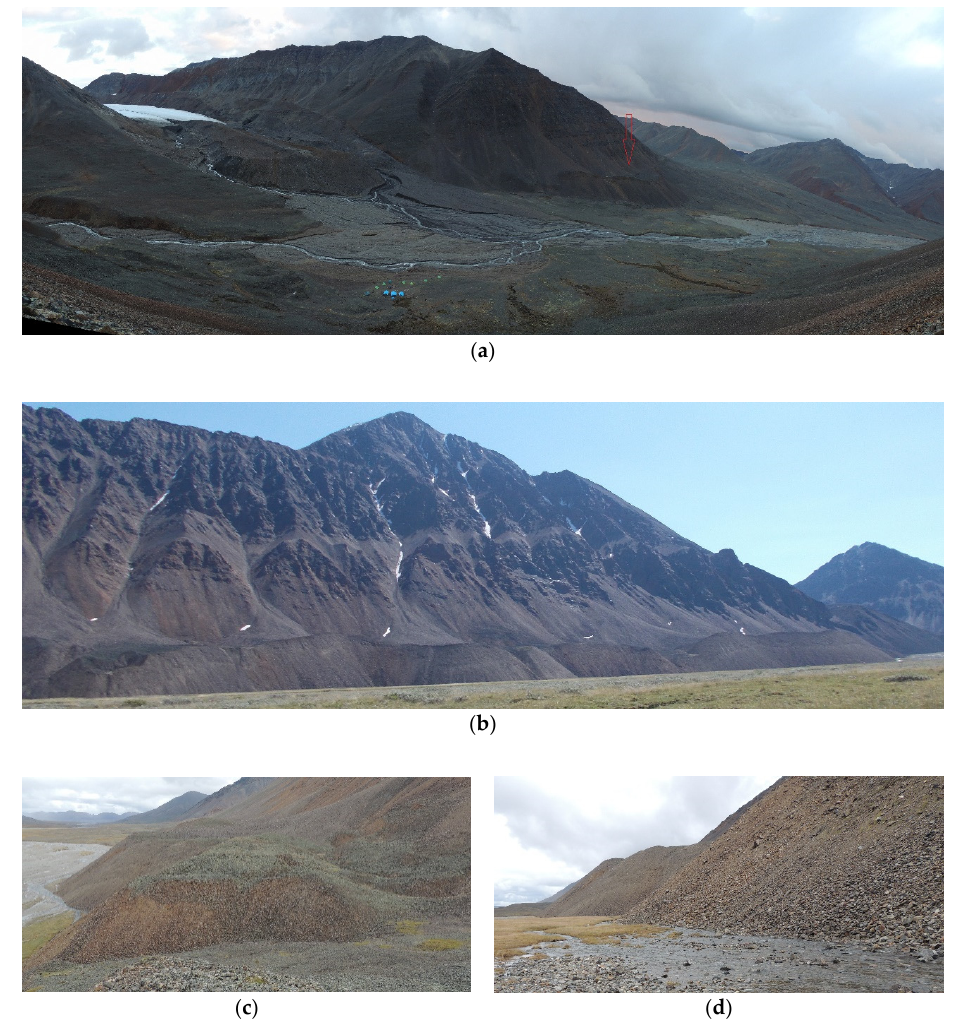
Figure 9. Footslope rock glaciers in the Burgali River Valley, Suntar-Khayata Range. ( a )— SX-1 , an active rock glacier at 1965 m asl; ( b )— SX-2 , a partially active footslope rock glacier at 1780 m asl; ( c )—surface of SX-2 rock glacier; ( d )—lobes of SX-2 extensive rock glacier. The multi-bladed sloping rock glacier No. SX-2 (62°39 ′ N; 140°52 ′ E) is located at a distance of about 8 km from the edge of glacier No. 31 on the right side of the River Burgali of the north-western exposure, in the altitude range of 1780–1820 m (Figure 8). It is formed by a series of merged blades up to 200 m long (Figure 9b), each of which feeds from 1–2 talus cones. The total width of the glacier reaches 1800 m, the area is 0.4 km 2 , and the maximum thickness is 70 m. Rock glacier crawls on the surface of the grassy-shrubby vegetation floodplain of River Burgali, whose height is 2–3 m. Its direct frontal slope with a steepness of 40–50° and a height of up to 70 m indicate a high activity. The edge and sole of the frontal slope are sinuous, which is associated with different activity and unequal speeds of movement of individual blades of this glacier. This is well reflected in the cover of lichens of the genus Rhizocarpon sp., which are completely absent in active sites of the frontal slope, and reach 20–30 cm in slow-moving ones.